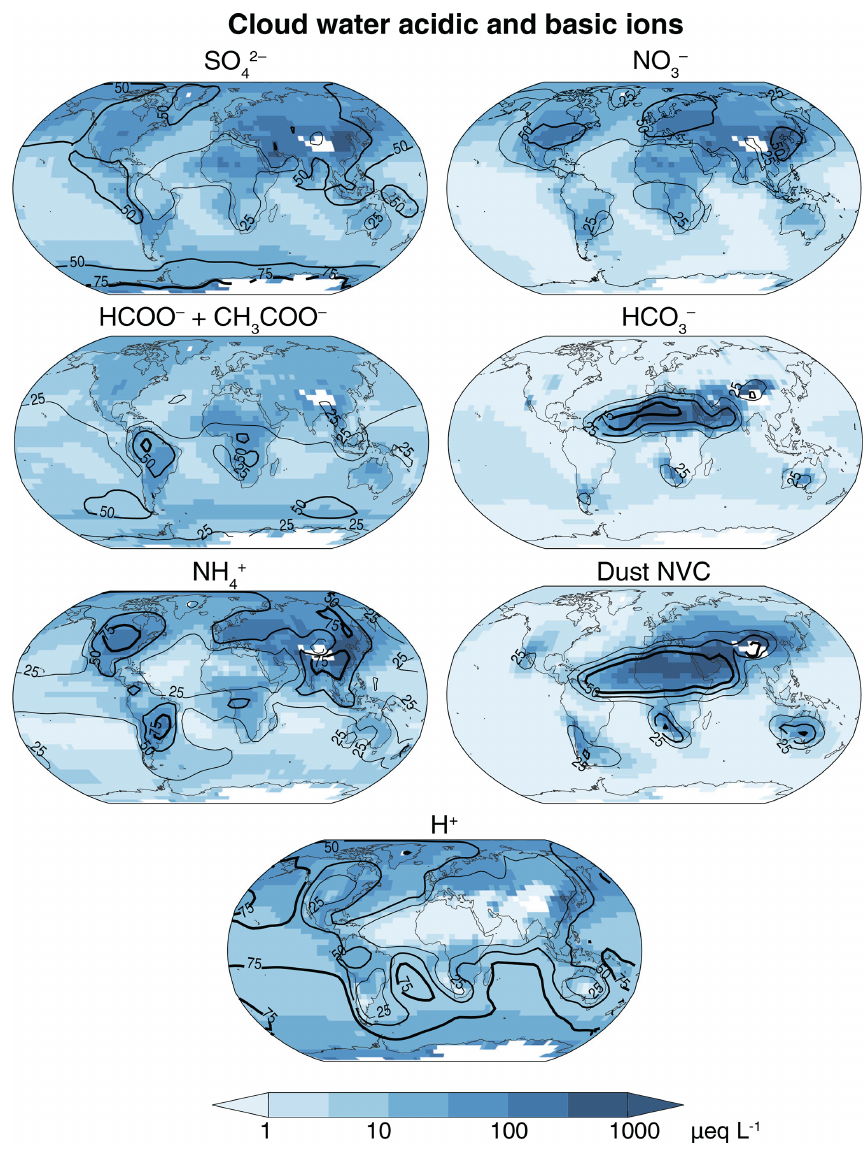
Figure 3. GEOS-Chem cloud water equivalent concentrations of major acidic and basic ions. Values are annual volume-weighted averages below 700hPa for the year 2013. The contour lines (25%, 50%, 75%) show the percent contribution of each ion to the total anion or cation equivalents. Na + and Cl − are not included in this total because they are largely in balance and make little net contribution to acidity. White color denotes areas where the topographic elevation is higher than